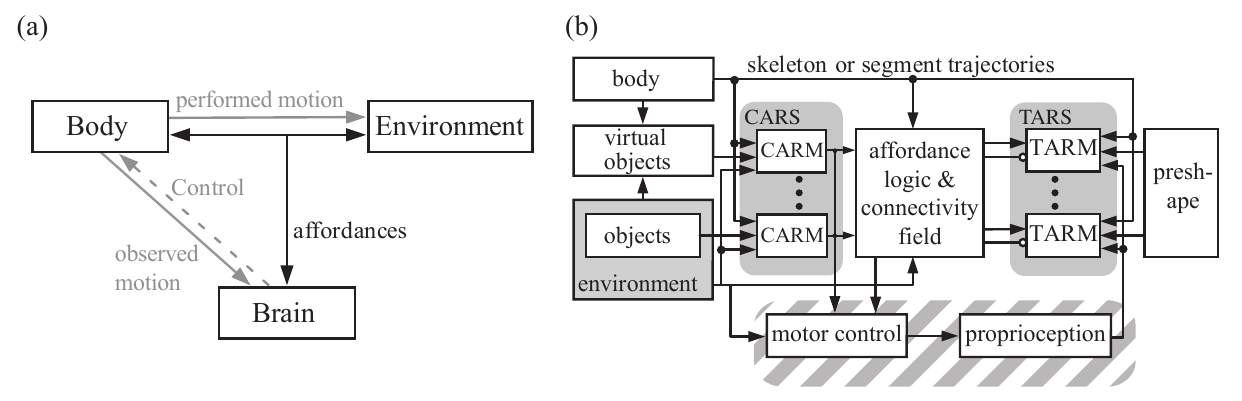
Figure 3. (a) Illustration of the interactions between brain, body and world or environment based on the contextual affordance input as well as the trajectory input information. (b) Connection of contextual- and trajectory based action recognition system. The hatched connections are used to represent possible connections and are not currently modeled in this